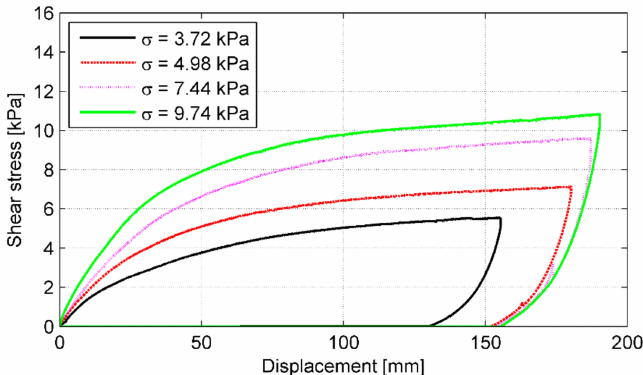
Figure 21. Shear stress–displacement curves for average front displacements in subsequent load stages for P-2 specimen.